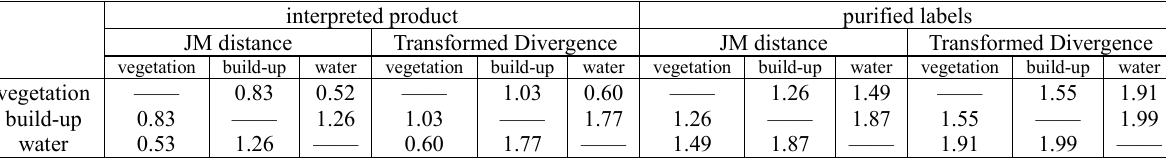
Table 3. The inter-class separability for Region 1